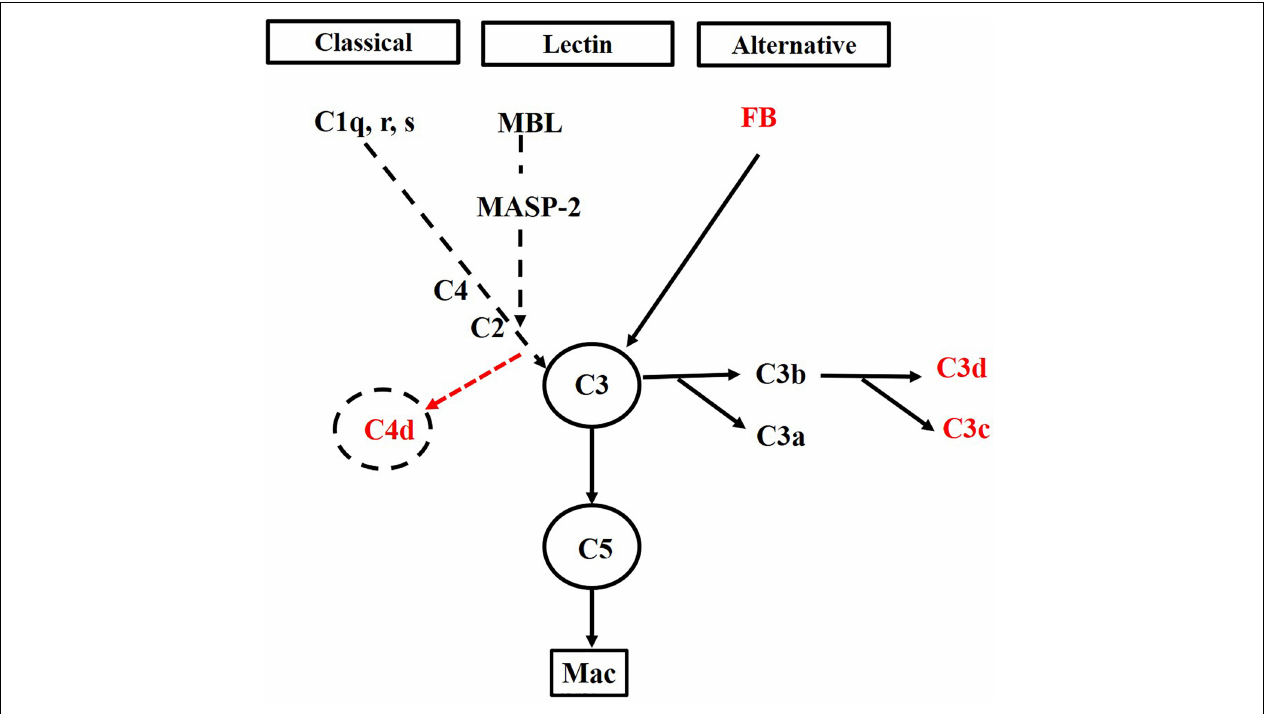
FIGURE 4 | The schematic diagram of complement activation pathway in our patients. Three pathways of complement activation exist: the classical, mannose-binding lectin (MBL), and alternative pathways. Activation of the classical pathway and the lectin pathway can cleave and activate C4 and C2 to form C4bC2a, which subsequently results in the formation of C4d. Activation of any of the three pathways leads to activation of C3, which generates C3a and C3b. Furthermore, C3b can generate C3c and C3d. The absence of C4 deposition in our patients suggests that both the classical and lectin complement pathways are not involved. On the contrary, the presence of FB, C3c, and C3d deposits demonstrates that the alternative complement pathway is activated in our